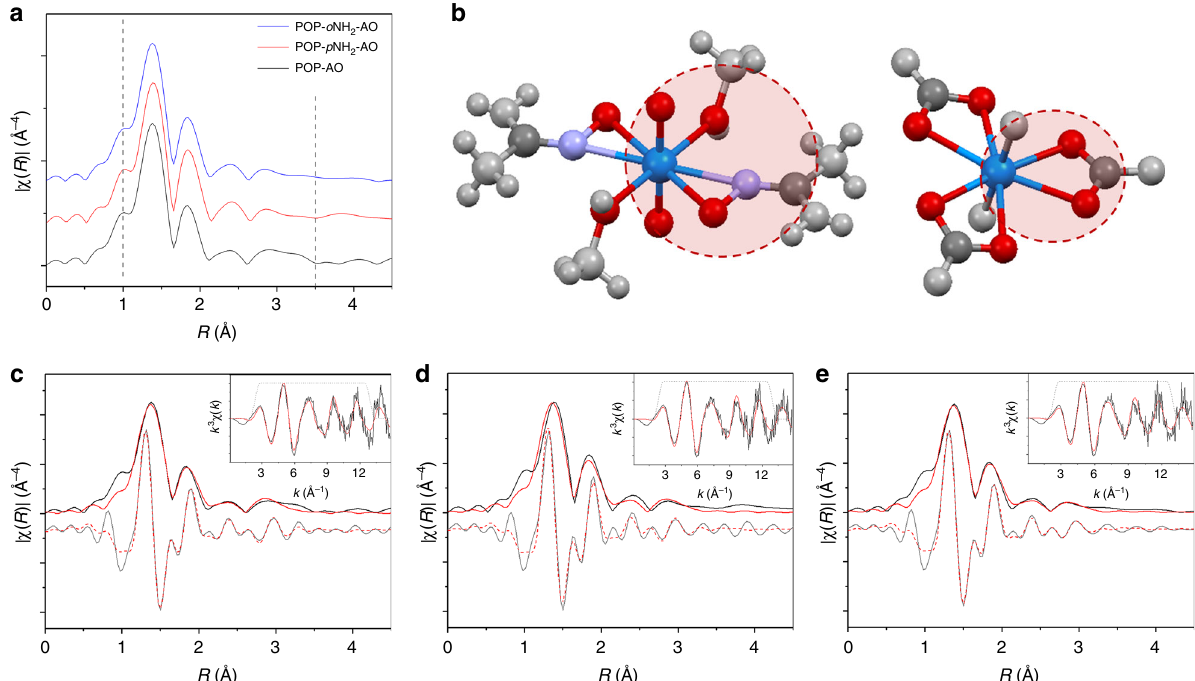
Fig. 5 EXAFS data, fi ts, and scattering paths. a A comparison of EXAFS spectra for U@POP-AO, U@POP- p NH 2 -AO, and U@POP- o NH 2 -AO revealing signi fi cant qualitative similarities. b Graphical depictions of the crystal structures used to generate theoretical scattering paths to fi t the EXAFS data. The dashed red circle displays the coordination shells for amidoxime- and carbonate-bound uranyl. Atoms displayed in light gray are not used to generate scattering paths but are included to display the complete molecular structure. EXAFS data and fi ts for c U@POP-AO, d U@POP- p NH 2 -AO, and e U@POP- o NH fi t for clarity. The magnitude of the Fourier transform is plotted in black, 2 -AO. The graphical depiction of the amidoxime species is displayed by each the real space component in gray, and fi ts in solid and dashed red, respectively. In all plots the inset is the k 3 -weighted χ ( k ) data and corresponding fi